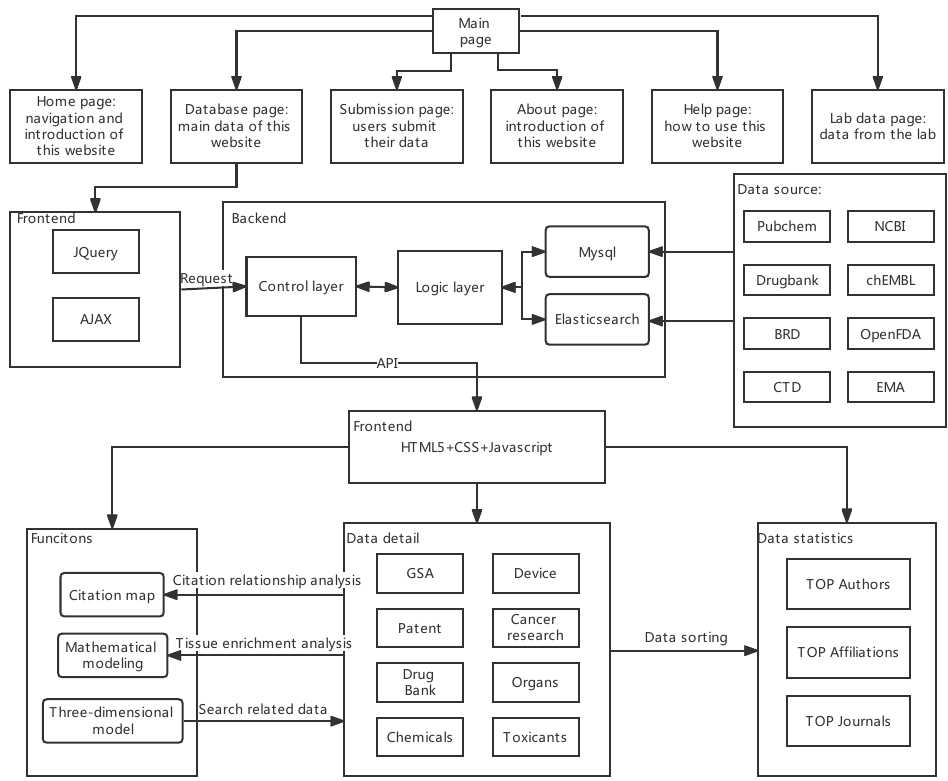
Figure 7. The main framework and construction of Ocdb. Six pages can be visited through the navigation bars, the most important of which is the database page. Based on the data the user wants to access, the front-end sends a request to the back-end. The back-end logic layer extracts and processes the data from MySQL and Elasticsearch, and the control layer distributes the requests and responses. The data sources of the Ocdb include Pubchem, NCBI, Drugbank, ChEMBL, BRD, OpenFDA, CTD, and EMA. Users can access three main functions, data details, and data statistics on the database